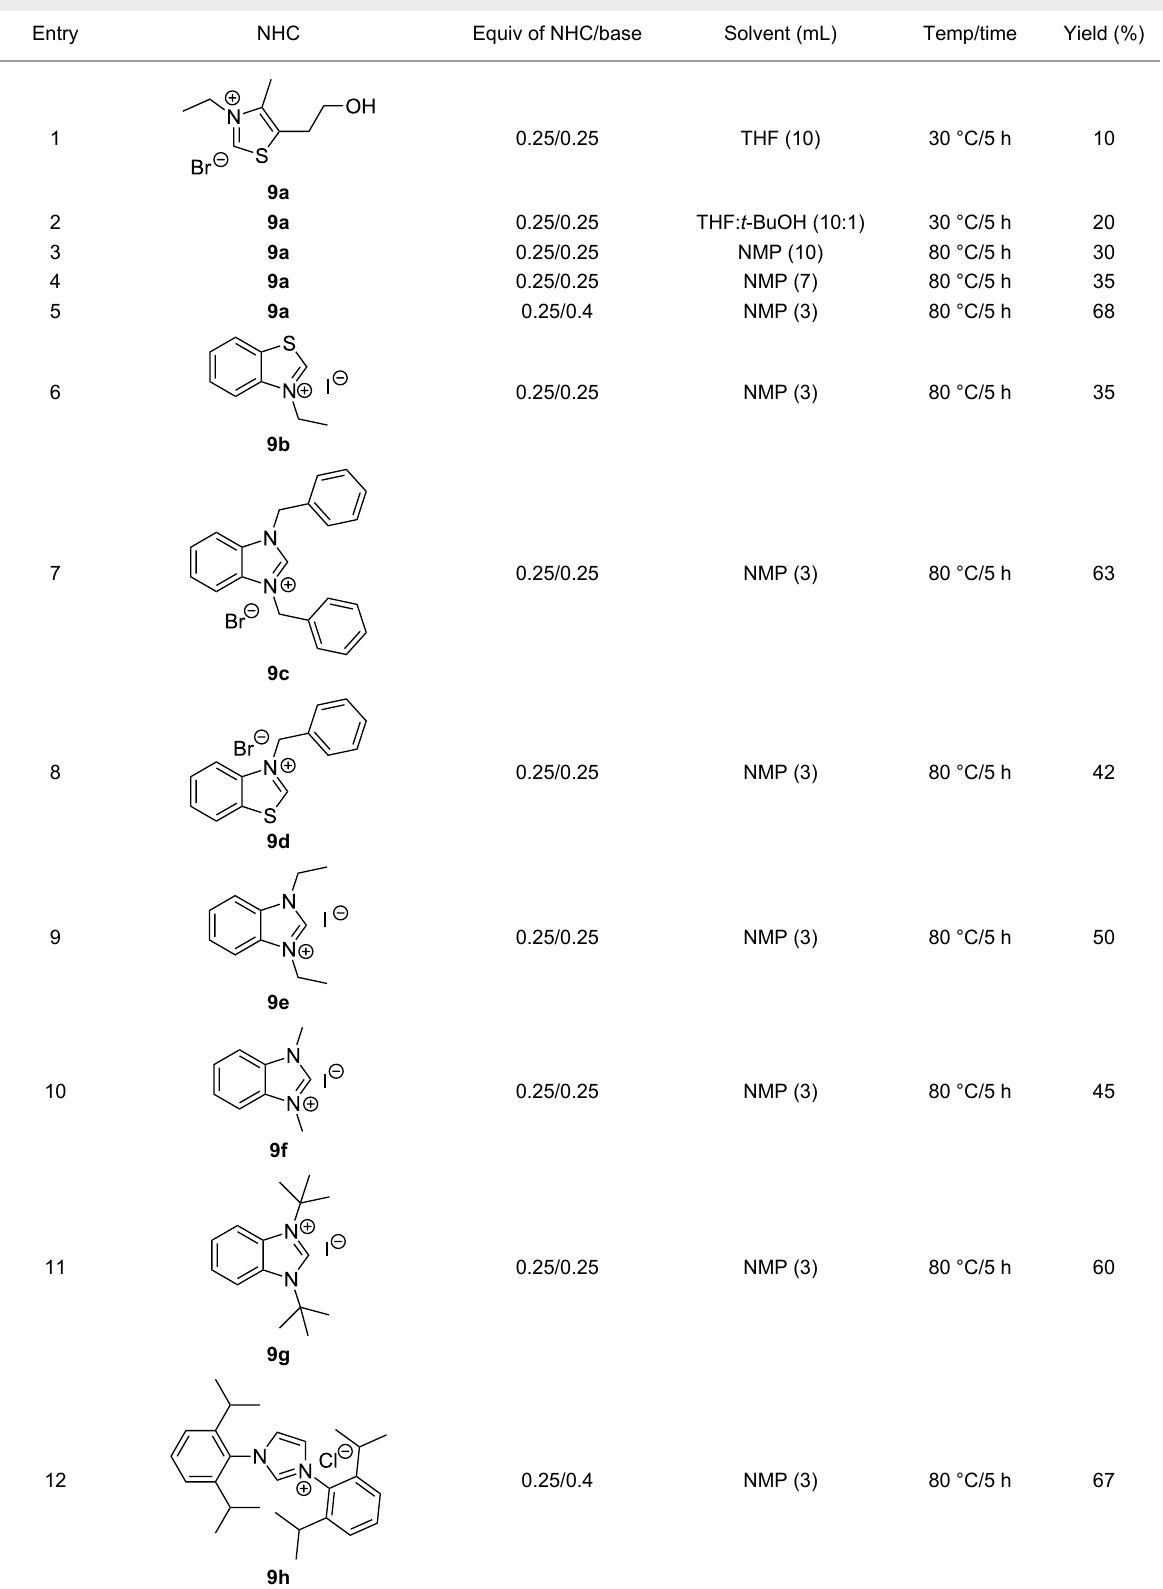
Table 1: Catalyst screening.